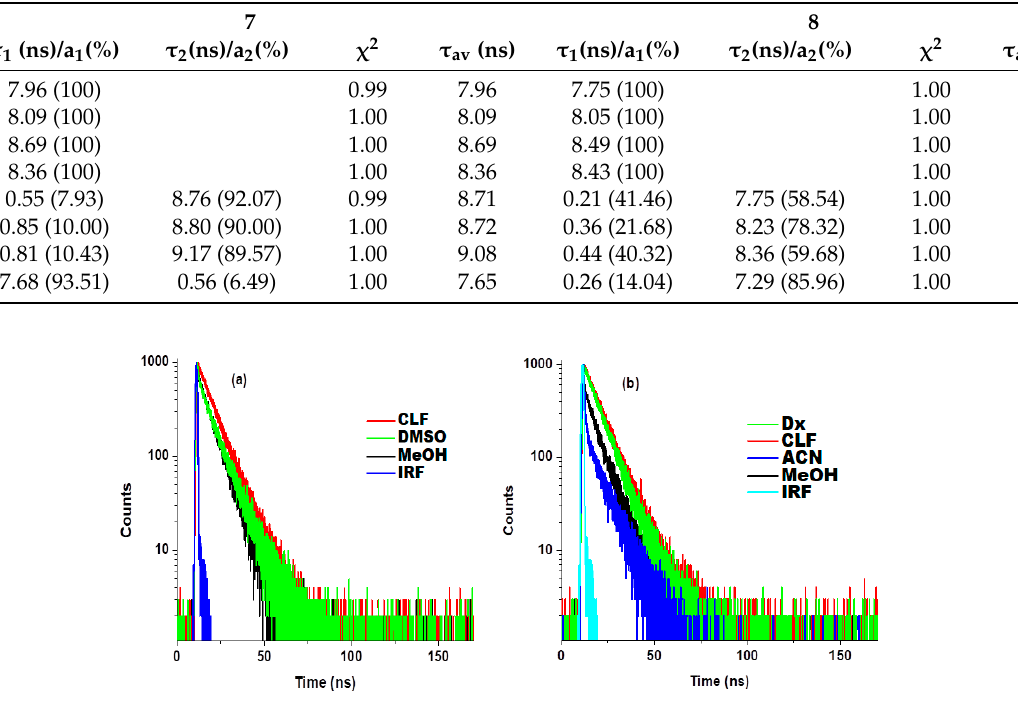
Figure 4. Fluorescence decay profiles of ( a ) 7 and ( b ) 8 in different solvents. In methanol, the measurements of the emission decay time indicated a longer time (7.68 ns) associated with a larger amplitude (93.51%) followed by a fast decay of 0.56 ns (amplitude 6.49%) for 7 , while for 8 the lifetime of the first component decay and the corresponding amplitude decrease significantly. The second decay component has a rel- atively longer lifetime and its amplitude becomes 85.96% in methanol. Moreover, the fluorescence decay profile of 8 is characterized by shorter lifetimes of the fast decay component and much higher amplitudes (Table 3). In polar solvents, the fitting of the experimental data shows a fast decay of 0.81 ns (amplitude 10.43%) for 7 in acetonitrile and of 0.55 ns (amplitude 7.93%) in DMSO. The long-lived components of 7 were around 9.00 ns with amplitude of approximately 90% in polar solvents. The emission decays of some naphthalimide derivatives fitted to biexponential curves in polar solvents were reported in literature [33,53]. The same pattern is valid for sample 8 in polar media, but the long-lived components have lower amplitudes (Table 3). The increase of the solvent polarity leads to the decrease of the fluorescence lifetimes and the same effect was found in the case of emission quantum yield (Table 1). The low amplitudes of short-lived components in polar media can be due to the enhanced charge transfer in polar solvents, and the short-lived components are not found out in solvents with low polarity. The in- crease of the nonradiative processes in the emission mechanism of piperi- dine-naphthalimides as the solvent polarity increases can be influenced by the intramo- lecular charge transfer mechanism. The rate constants of radiative (k r ) and nonradiative (k nr ) decay can be estimated by the following relations: 𝑘 (cid:3045) = Φ 𝜏 (2)